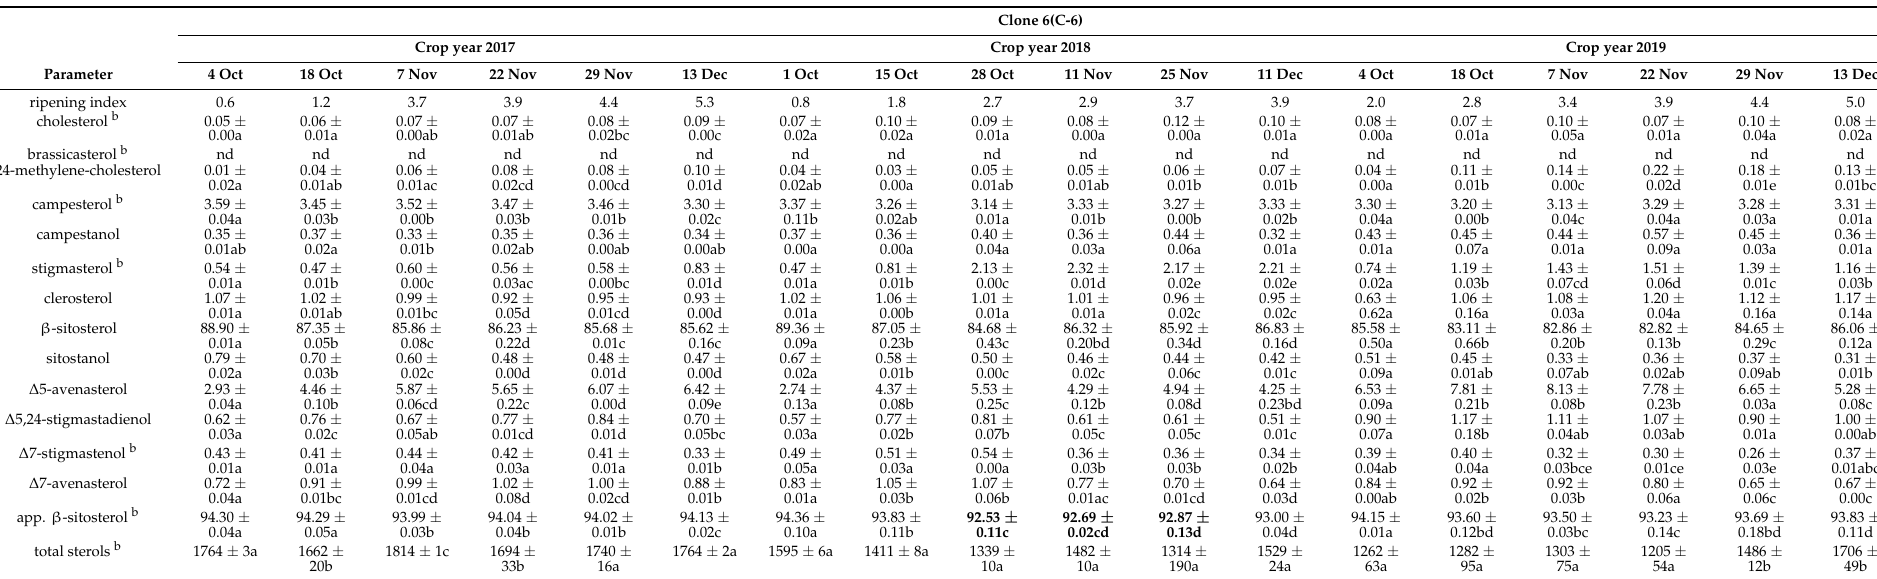
Values are mean ± standard deviation ( n =2). a Different letters for each parameter indicate significant statistical differences ( p < 0.05) among picking dates for each crop year (a–f). b Limits established by the current regulation: total sterols ≥ 1000 mg/kg; cholesterol ≤ 0.5%; brassicasterol ≤ 0.1%; campesterol ≤ 4.0%; stigmasterol ≤ campesterol; ∆ 7-stigmastenol ≤ 0.5%; app. β -sitosterol ≥ 93.0%. Values in bold: non-compliance. Not detected =